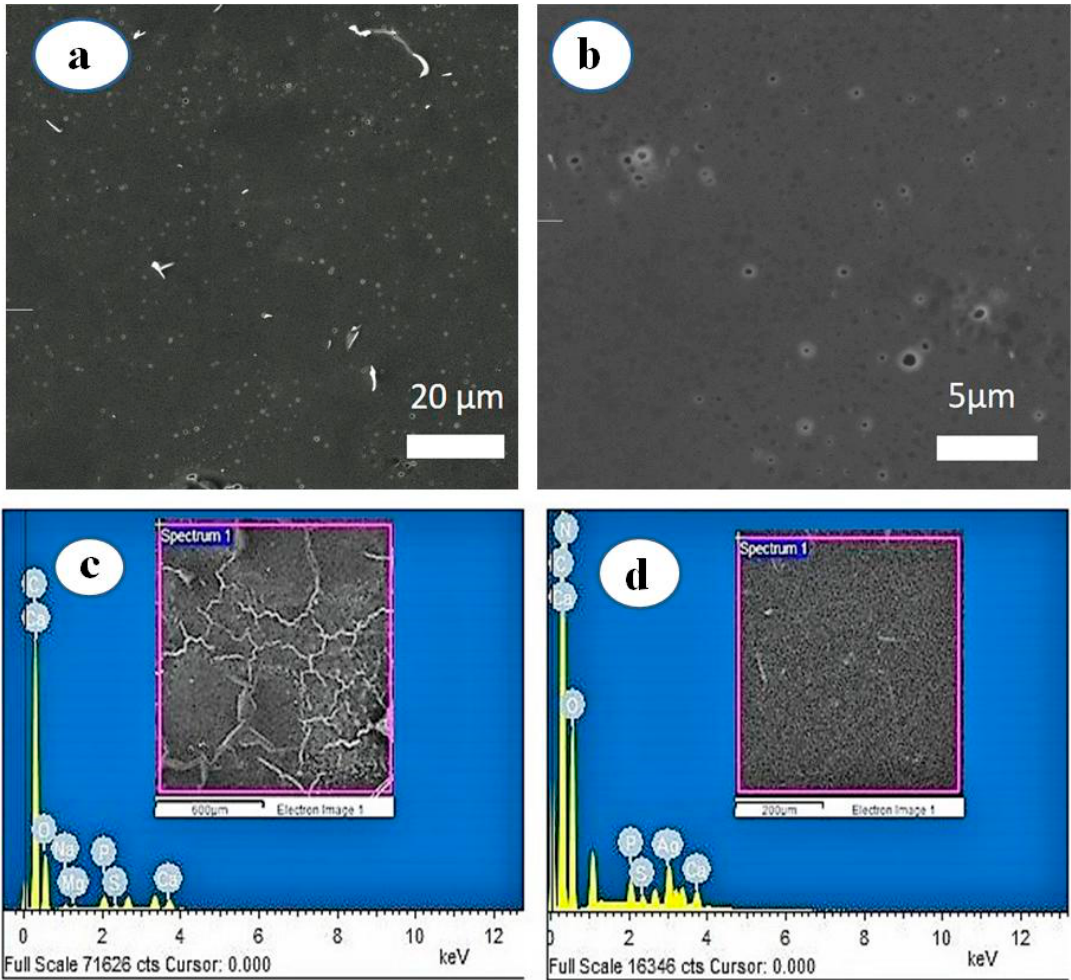
Figure 4. SEM images of AgNPs synthesized by commercial milk. ( a ) At lower magnification and ( b ) at higher magnification and EDS profiles of ( c ) commercial milk and ( d ) MP-s-AgNPs.